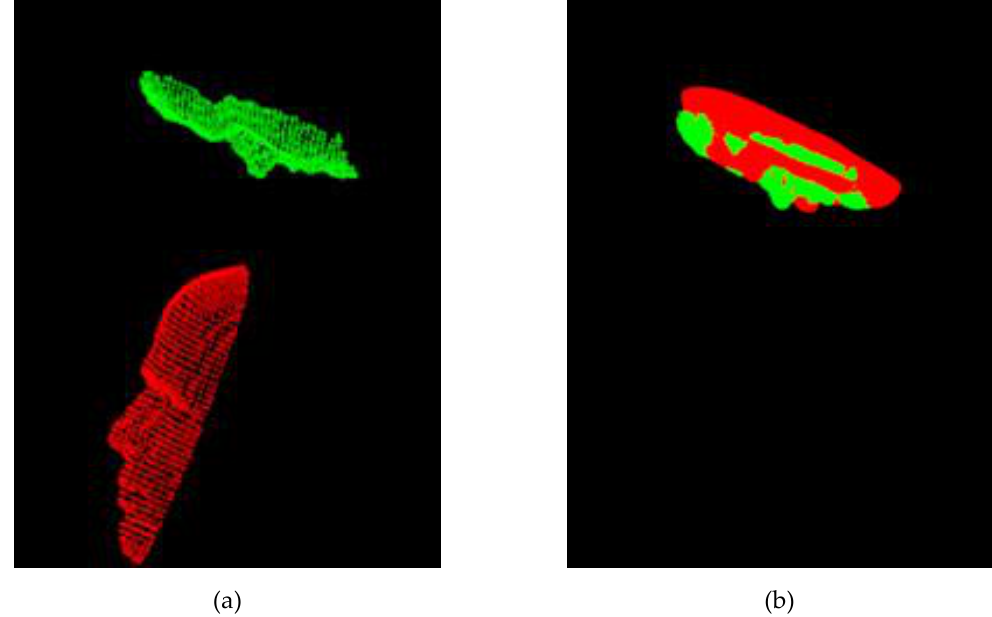
Figure 7. A possible scenario of ( a ) pre-coarse-alignment ( b ) post-coarse-alignment positions. Table 7. Average RMS errors of five reference points after coarse-Alignment for original data (mm).